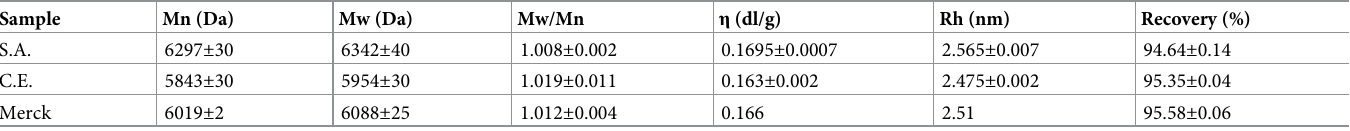
Table 1. Triple SEC measurement with PEG6000 from S.A., C.E., and Merck. Sample